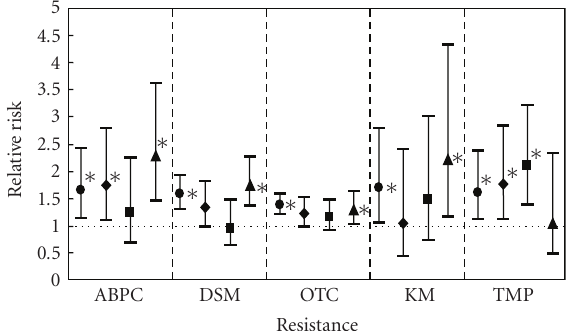
Figure 4: Relative risks of antimicrobial resistance in porcine E. coli isolates due to exposure to antimicrobials mainly used in Japan. a Symbols indicate the values of relative risk of each resistance due to exposure to tetracycline antibiotics ( ), penicillin antibiotics ( (cid:2) ), methoprims-sulfonamides combination drugs ( (cid:3) ), and penicillin- streptomycin combination drugs ( (cid:4) ). ∗ In case that 95% confidence interval ( ) does not include the value 1, the relative risk is considered statistically significant ( P < . 05). This figure is based on the data obtained from the previous manuscript mentioned in